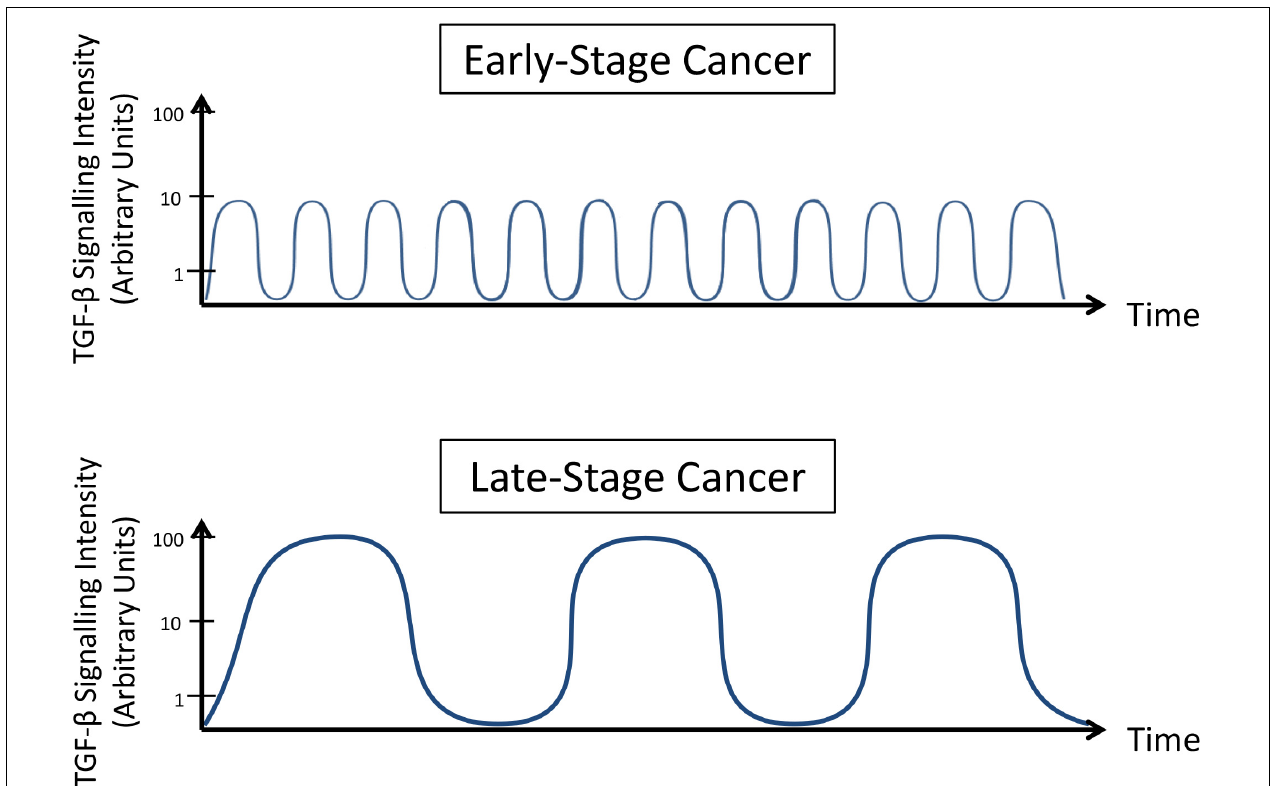
FIGURE 3 | TGF- β signaling dynamics change during cancer progression. Late-stage cancer cells present increased intensity and reduced frequency oscillation in TGF- β signaling pathway activity compared to early stage cancer